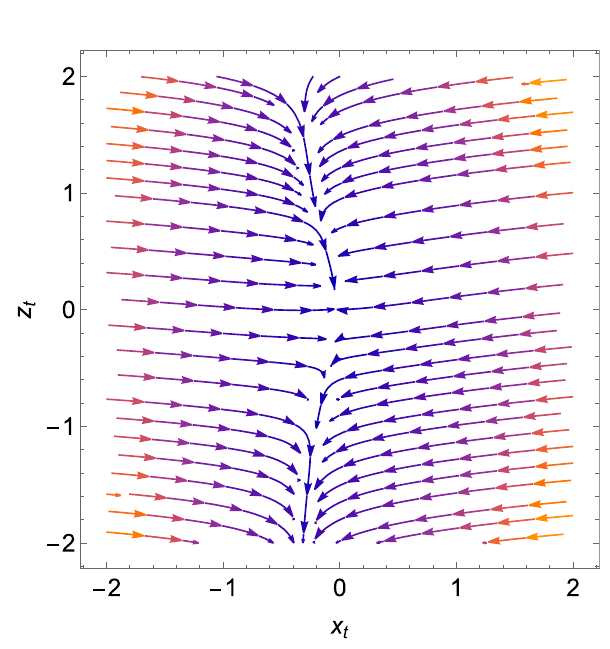
Fig. 3 Vector field projection on x t z t coordinate plane when c = 3 for fixed point D for λ = 0 . 5 and coupling constant ‘C’ =